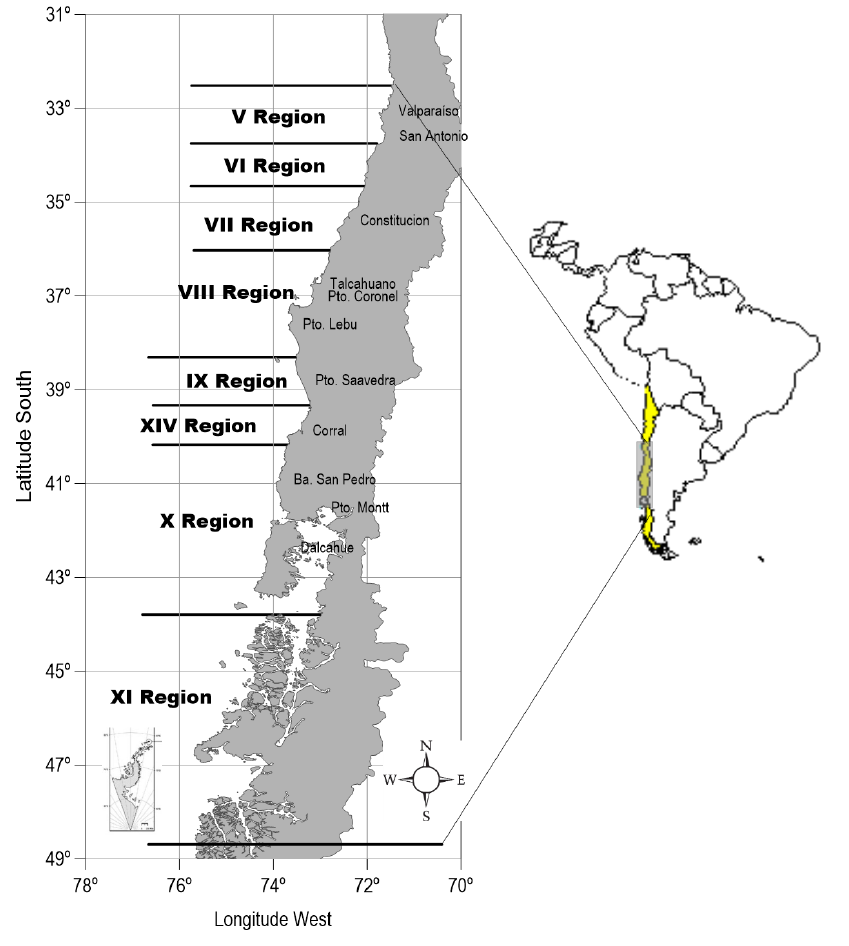
Figure 1. Study area restricted in Central-South Chile (32 ◦ 10 (cid:48) –40 ◦ 14 (cid:48) LS). The solid black lines correspond to regional